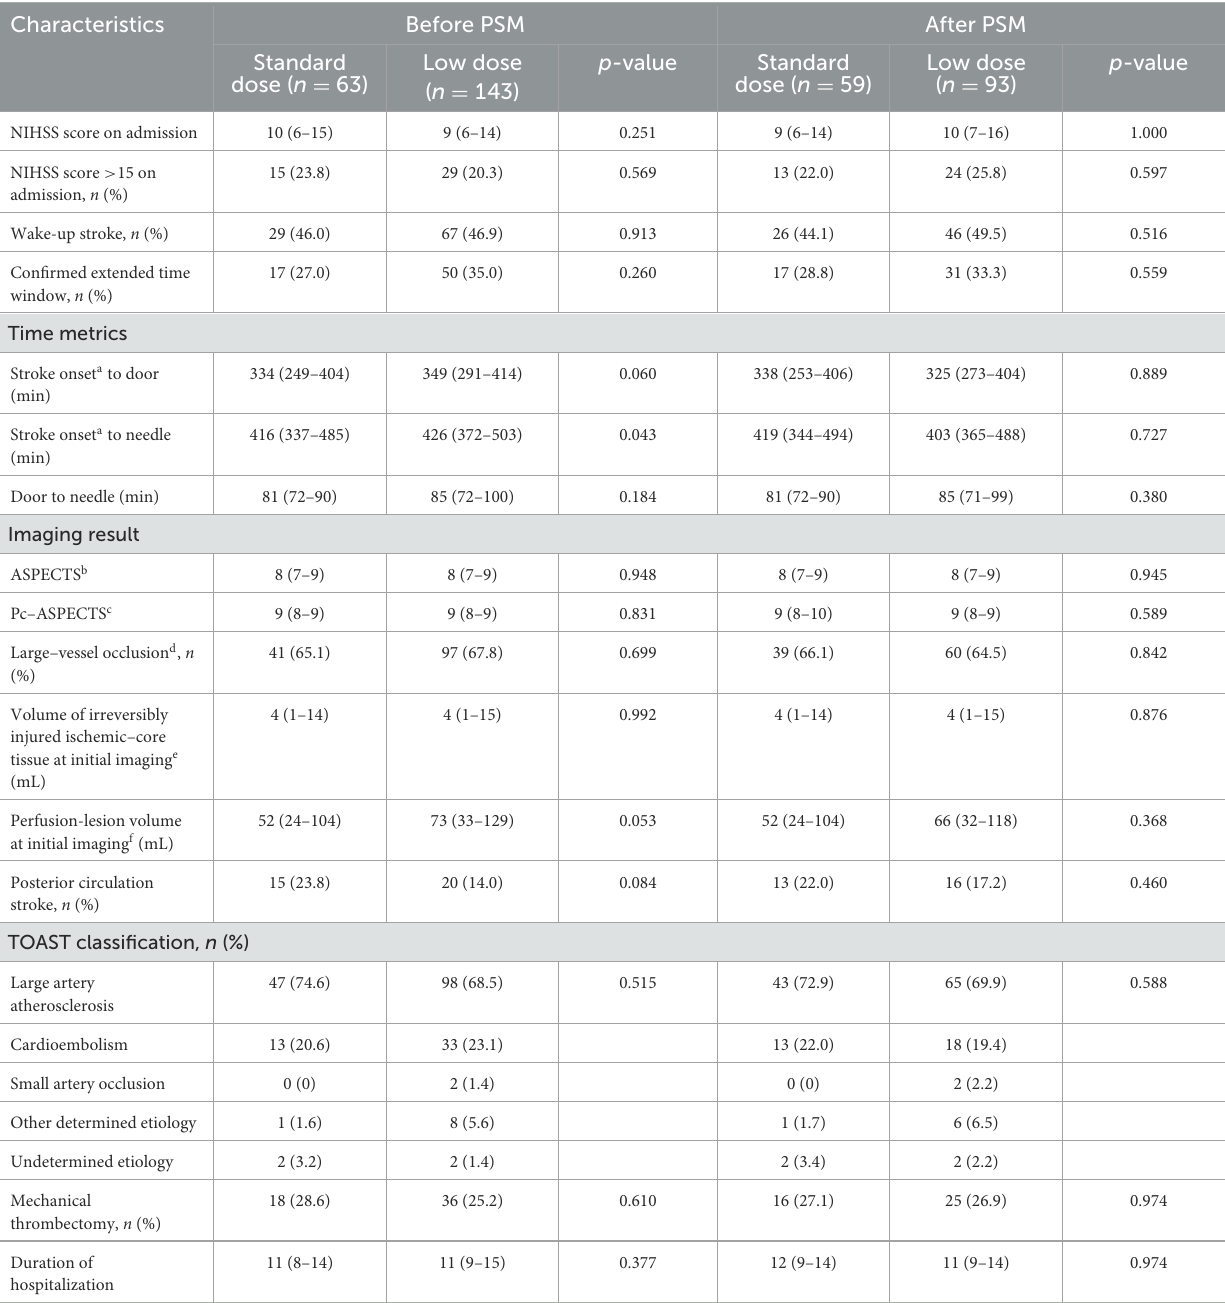
TABLE 2 Clinical and imaging characteristics of patients treated with standard- vs. low-dose alteplase before and after PSM.